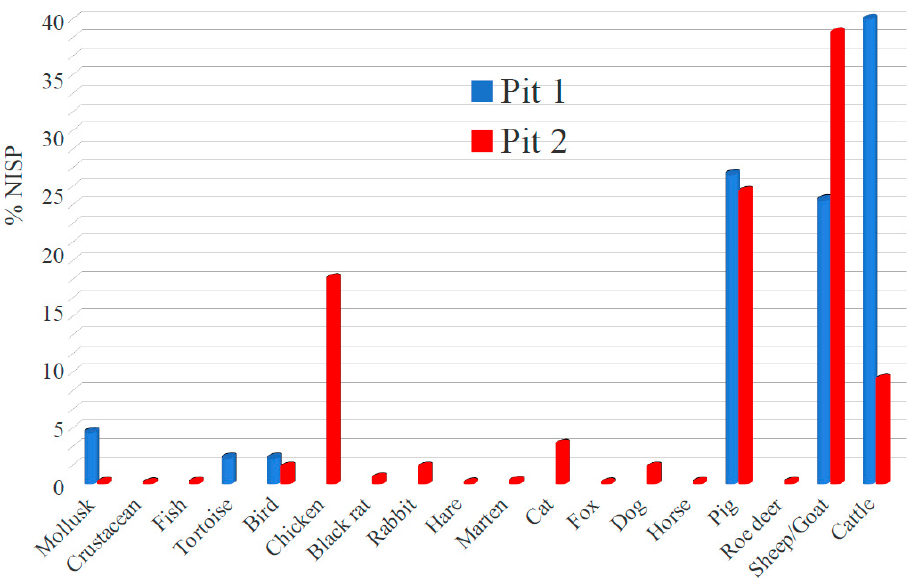
Figure 2. Species composition and proportion of the faunal samples from the two pits. The NISP (Number of Identified Specimens) is 1319 and 45 in pit 2 and pit 1, respectively, not including the unidentifiable fragments.